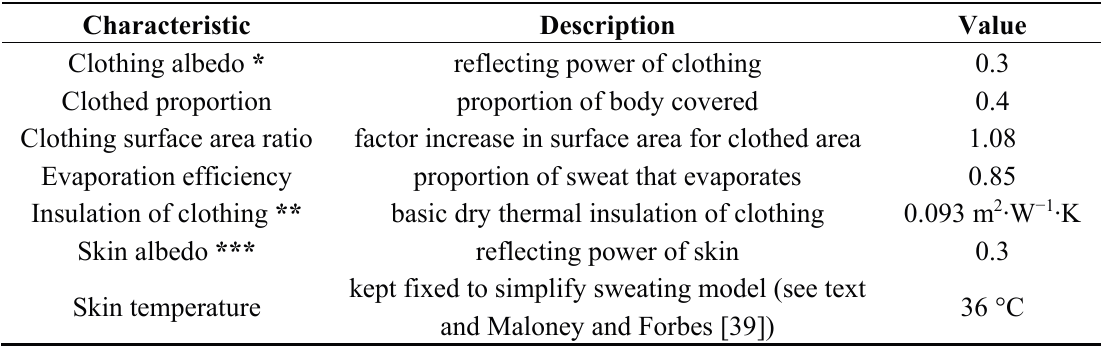
Table 1. Fixed values in the MANMO model [24] as implemented by Maloney and Forbes [39]. All are dimensionless unless otherwise indicated in the table. Figure 1 indicates the role that these values play in the